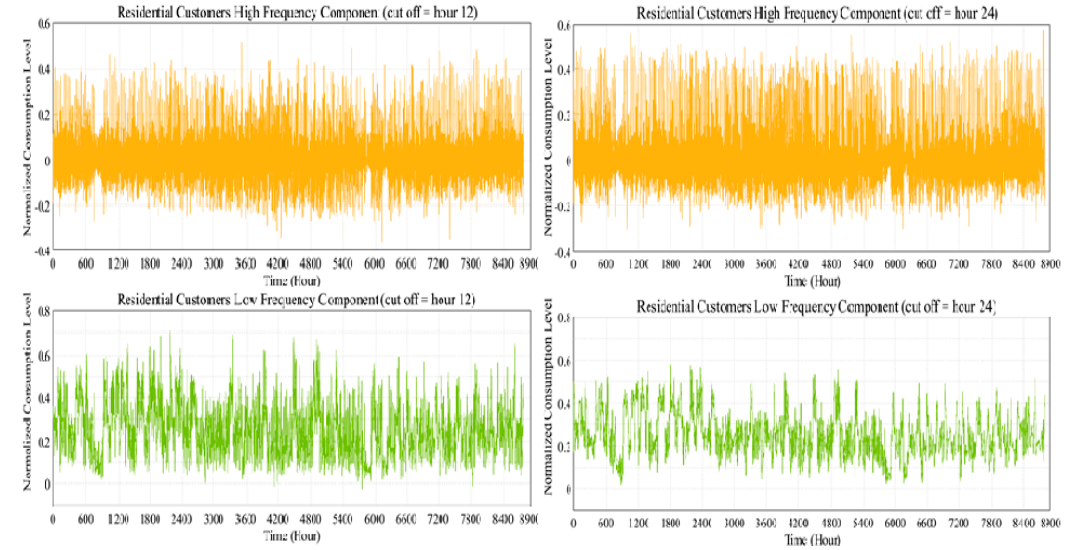
Figure 3. Time-domain electricity consumption signals for individual residential customers.